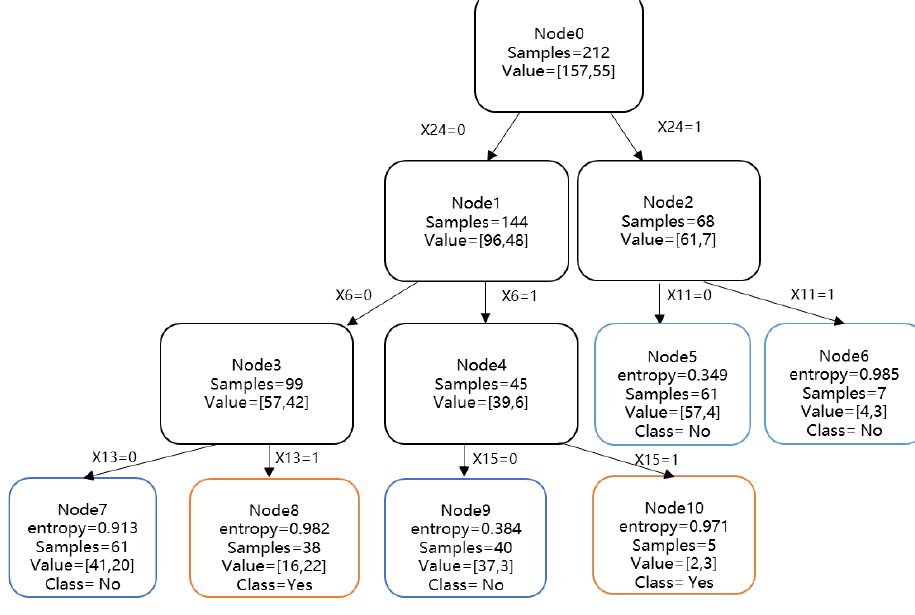
Figure 3. Statistical analysis results of the decision tree.